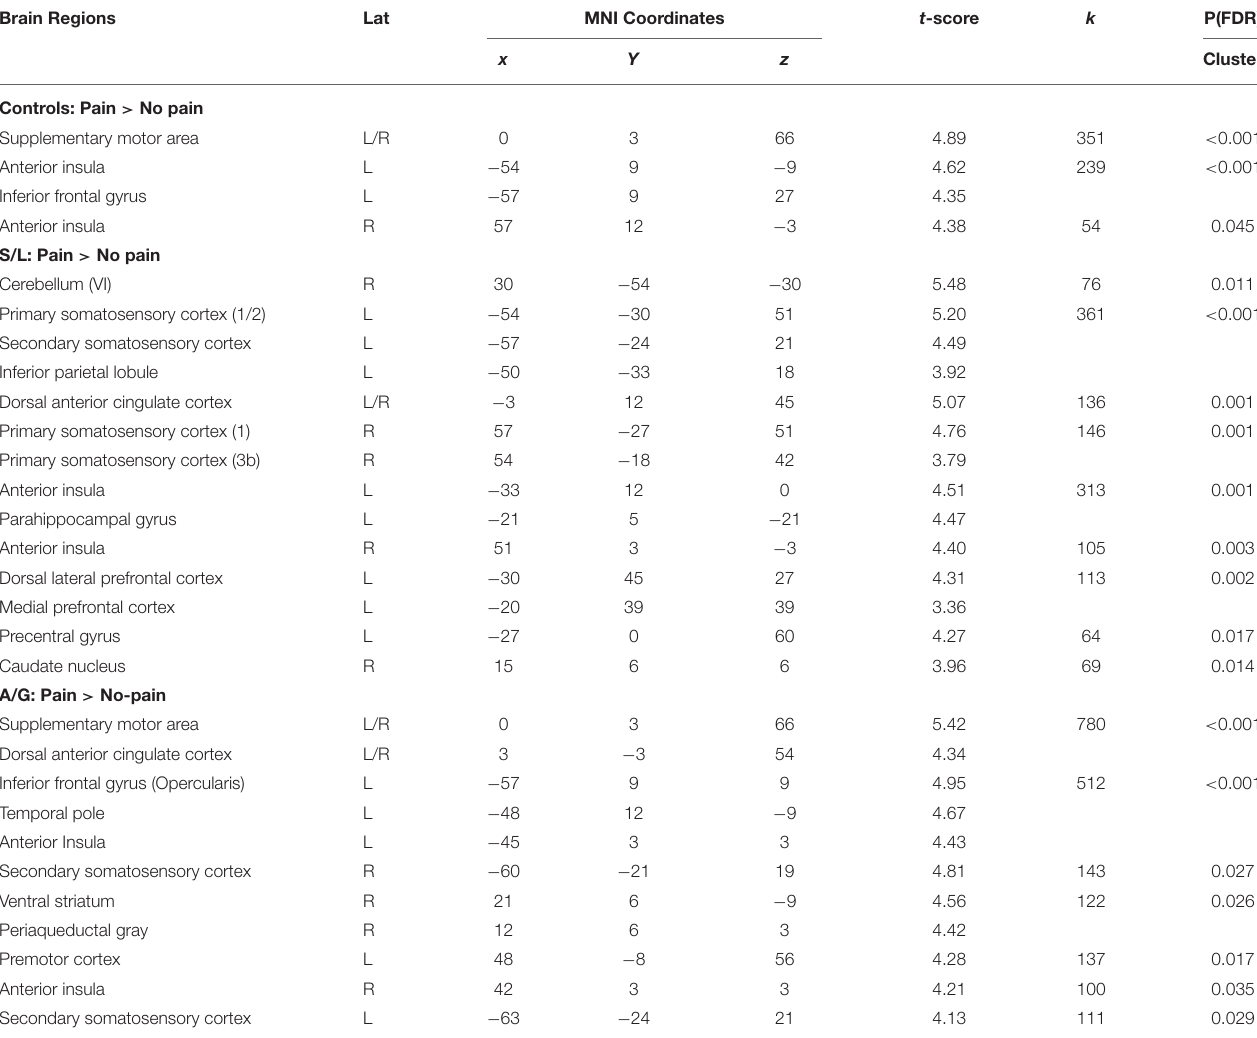
TABLE 2 | Regions showing significant within group effects in Pain > No-pain image contrasts. Peak MNI effects are displayed for each effect as well as FDR corrected cluster significance values. Brain